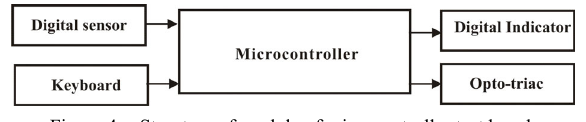
Figure 4. Structure of module of microcontroller test bench